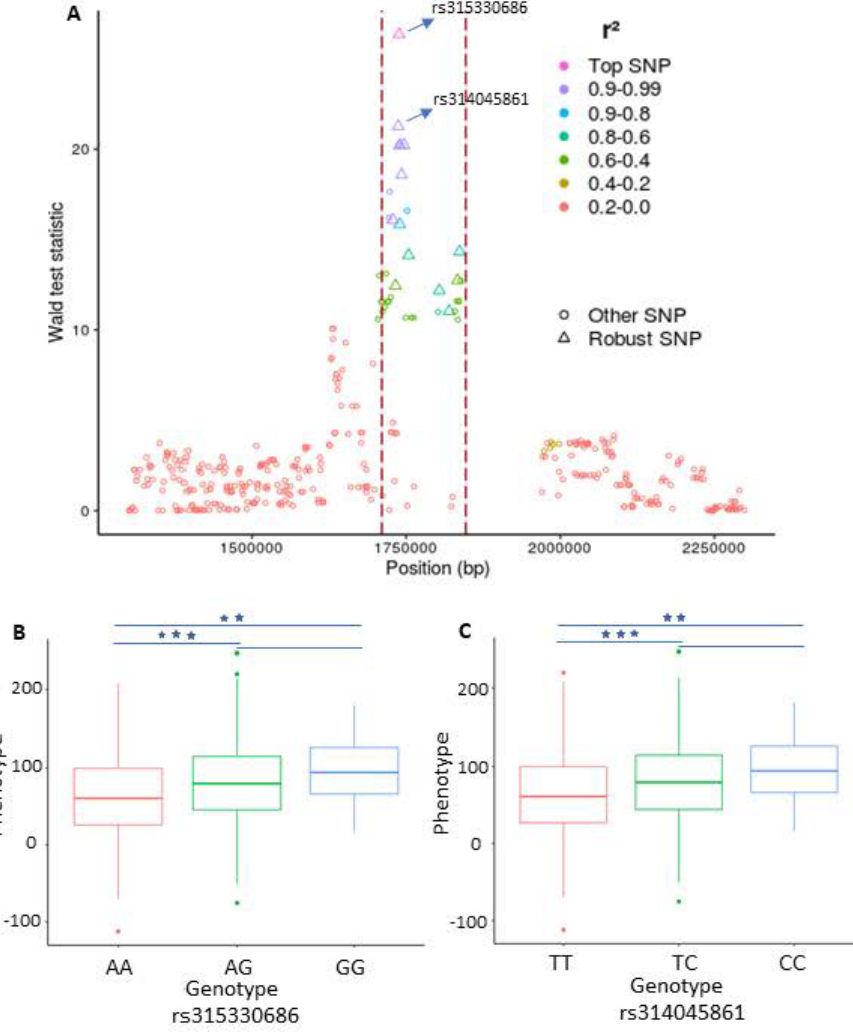
Figure 3. Plot representing a genomic region on chromosome 18 which is in association with eggshell strength at time point 1 (ESS1). ( A ) Plot representing the linkage disequilibrium (LD) structure inside and around a significant peak. The dotted red lines depict the boundaries of the peak. Each point represents a single nucleotide polymorphism (SNP) and the color shows the strength of LD between the top SNP inside the peak and the SNP surrounding it. The diamond shape points inside the peak depict the robust SNPs. The X-axis contains the SNP positions on the chromosome while the y-axis depicts the Wald statistic values obtained from the single-SNP based genome wide association study (GWAS) analysis. ( B , C ) The effects of different genotypes of the two leading SNPs identified in the combined framework for ESS and their significance ( ∗∗ p < 0.01, ∗∗∗ p < 0.001 )